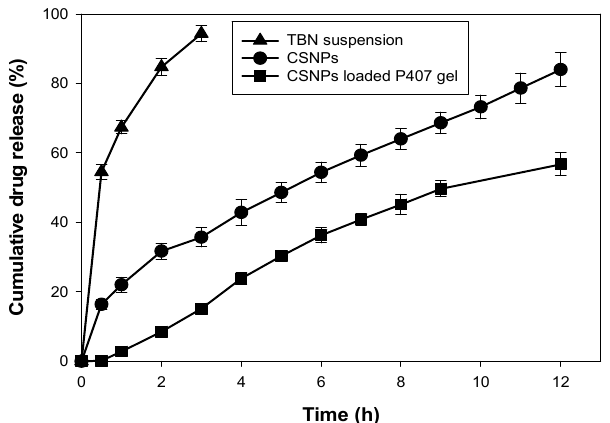
Figure 8. In vitro drug release profile of TBN-CSNP, TBN-CSNP loaded P407 gel and TBN suspension. Each value represent mean ± S.D ( n = 3).